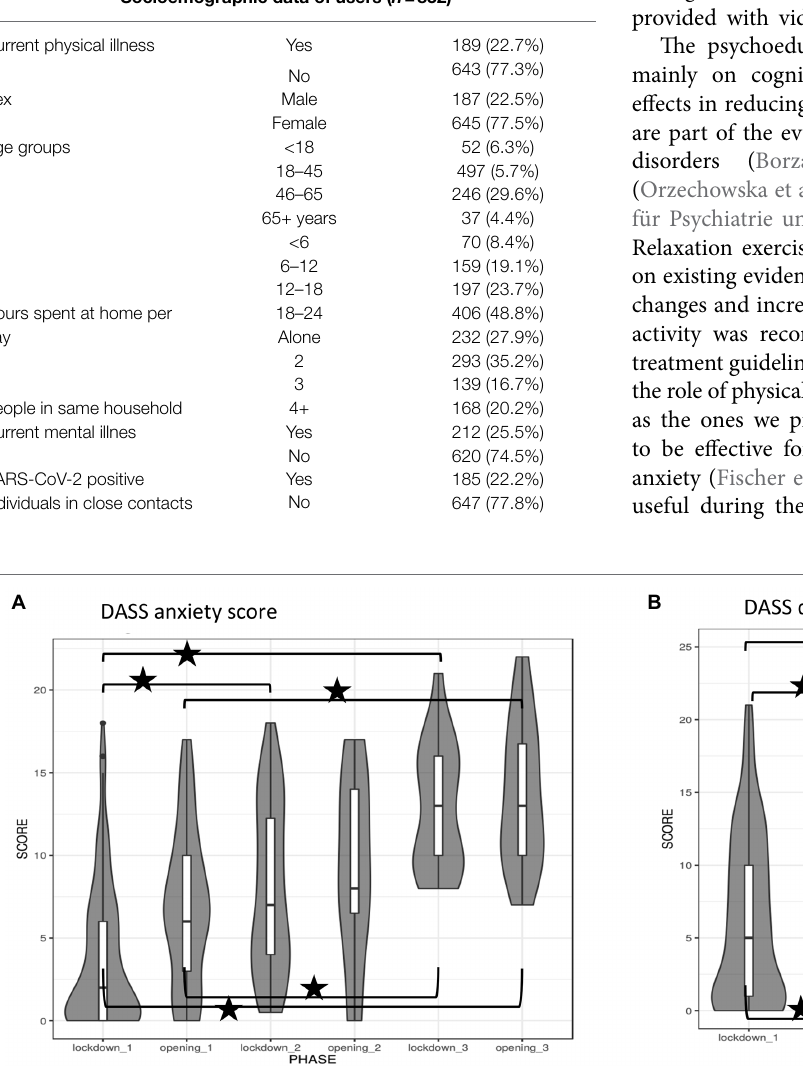
TABLE 1 | Sociodemographic data collected via the website in the first year. Socioemographic data of users ( n =